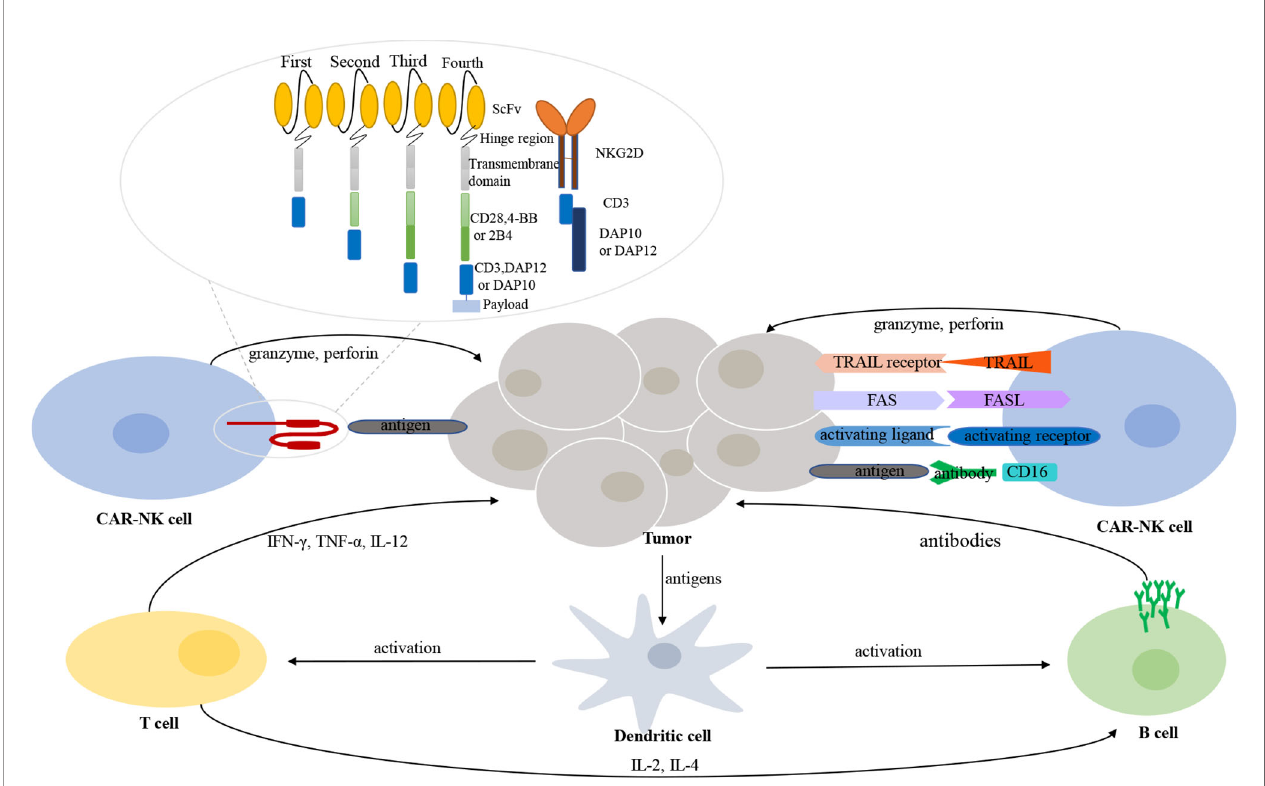
FIGURE 1 | The interaction between immune cells and tumor cells in tumor microenvironment. CAR-NK cells recognize and exert their killing effects through both CAR-dependent and CAR-independent manners. Different generations and types of CAR-NK cells. A CAR structure contains an extracellular binding domain (e.g., ScFv or NKG2D), a hinge region, a transmembrane domain, and one or more intracellular signaling